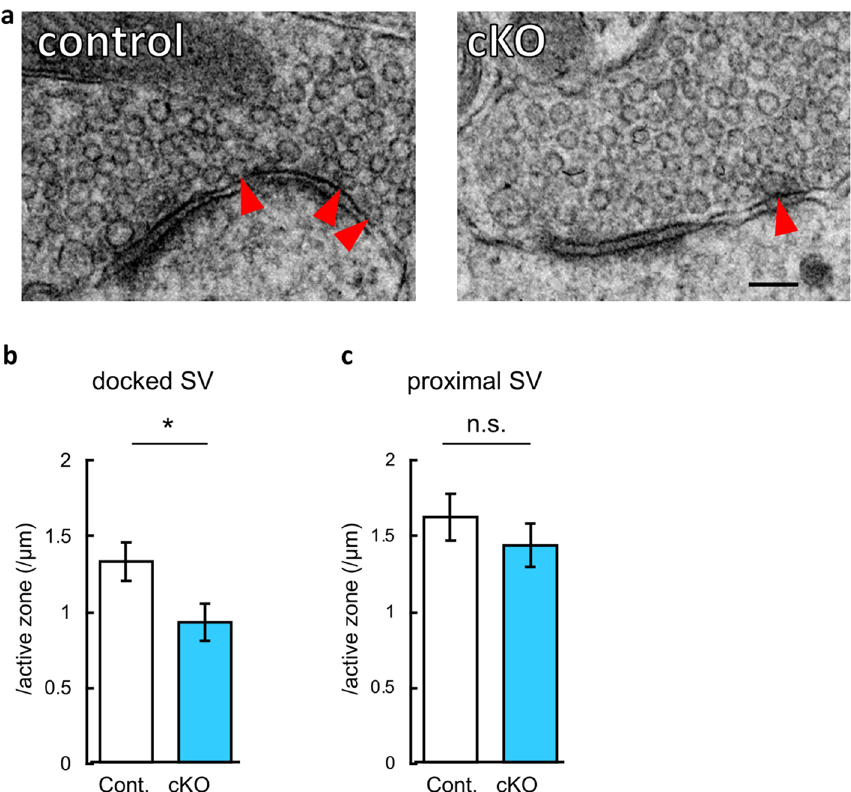
Figure 3. Electron microscopic analyses of the stratum lucidum of the CA3 region in the Caps1 cKO hippocampus. ( a ) Representative electron microscopic images of mossy fiber terminals. The red arrowheads indicate docked SVs on the active zones; Scale bar, 100 nm. ( b ) Number of SVs docked on the active zones in a mossy fiber terminal. Control, n = 71 active zones from 3 animals; Casp1 cKO, n = 75 active zones from 3 animals; P = 0.028, Student’s t -test. ( c ) Number of SVs in the proximity of the active zones (within 50 nm, but not docked) in a mossy fiber terminal. Control, n = 71 active zones from 3 animals; Casp1 cKO, n = 75 active zones from 3 animals; P = 0.320, Student’s t